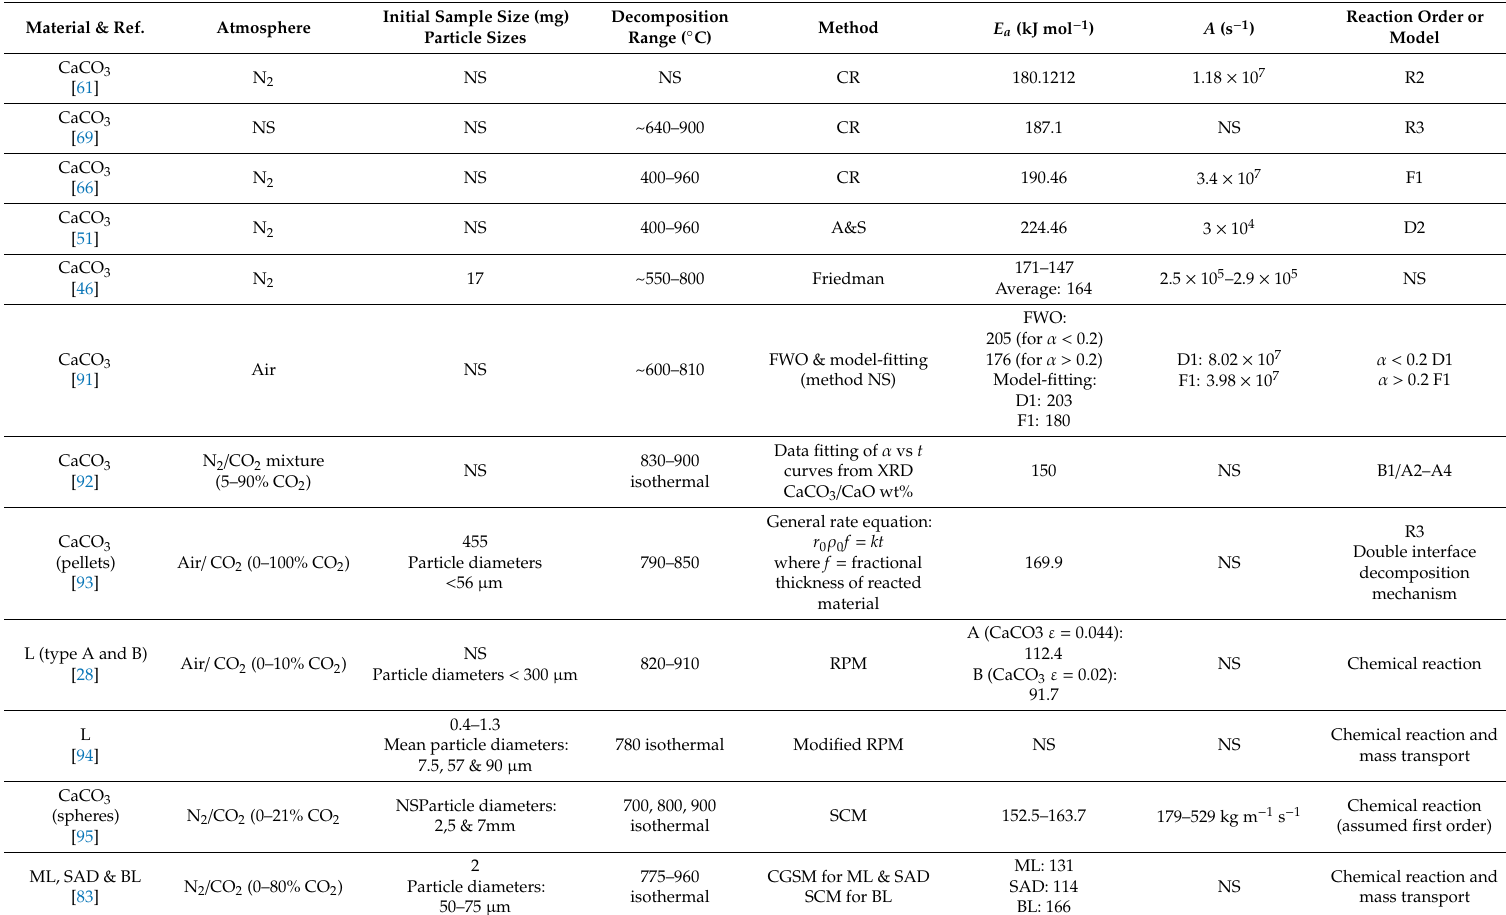
Table 2. Classification of kinetic models for reaction mechanisms. NS = not specified. For Coats-Redfern (CR) / Agarwal and Sivasubramanium (A&S) methods, kinetic parameters are average values from all heating rate experiments. Material &